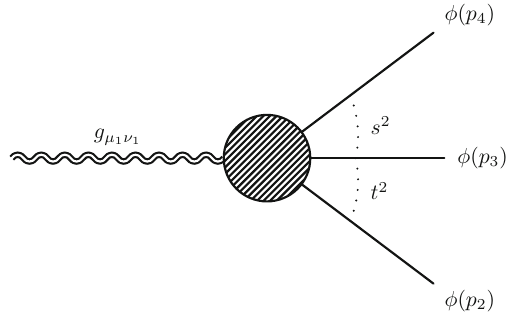
Fig. 5 The T OOO in a kinematical region in which can be described as a 1 → 3